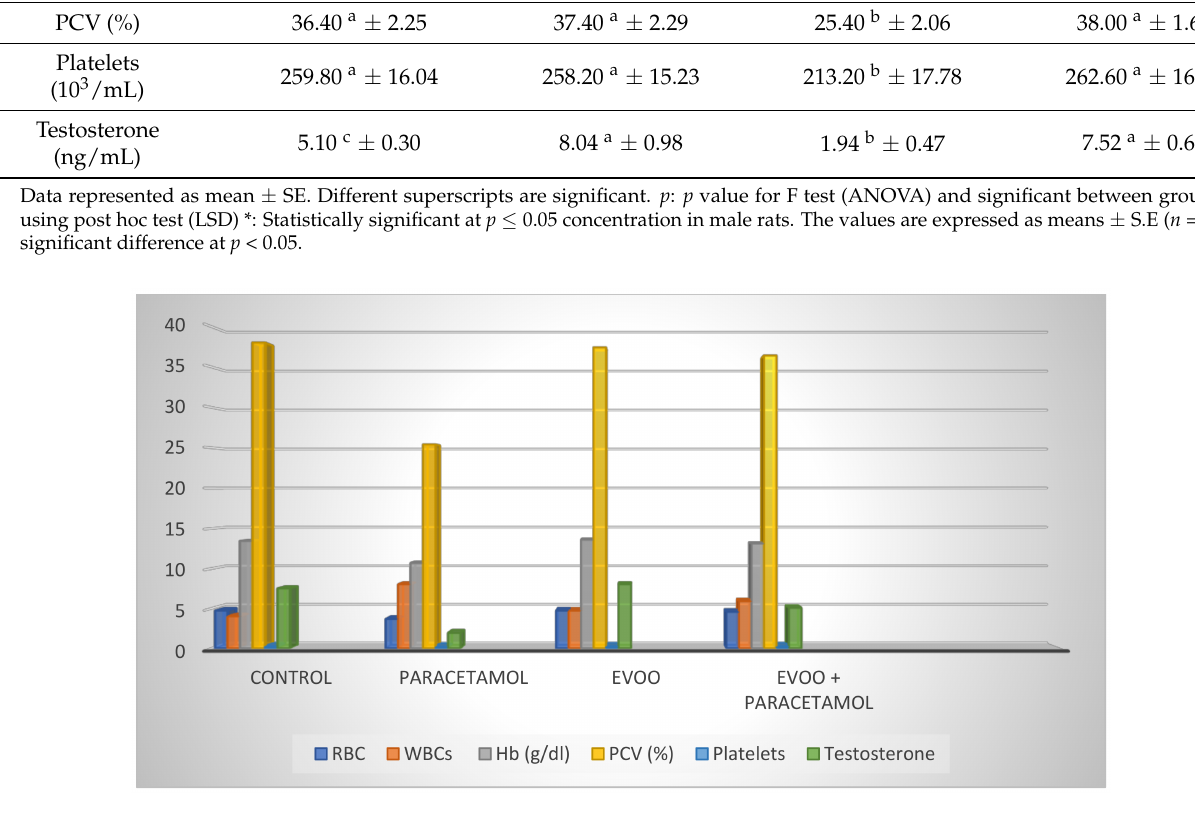
Figure 11. Protective effect of EVOO against paracetamol toxicity in blood and testis in male Wistar